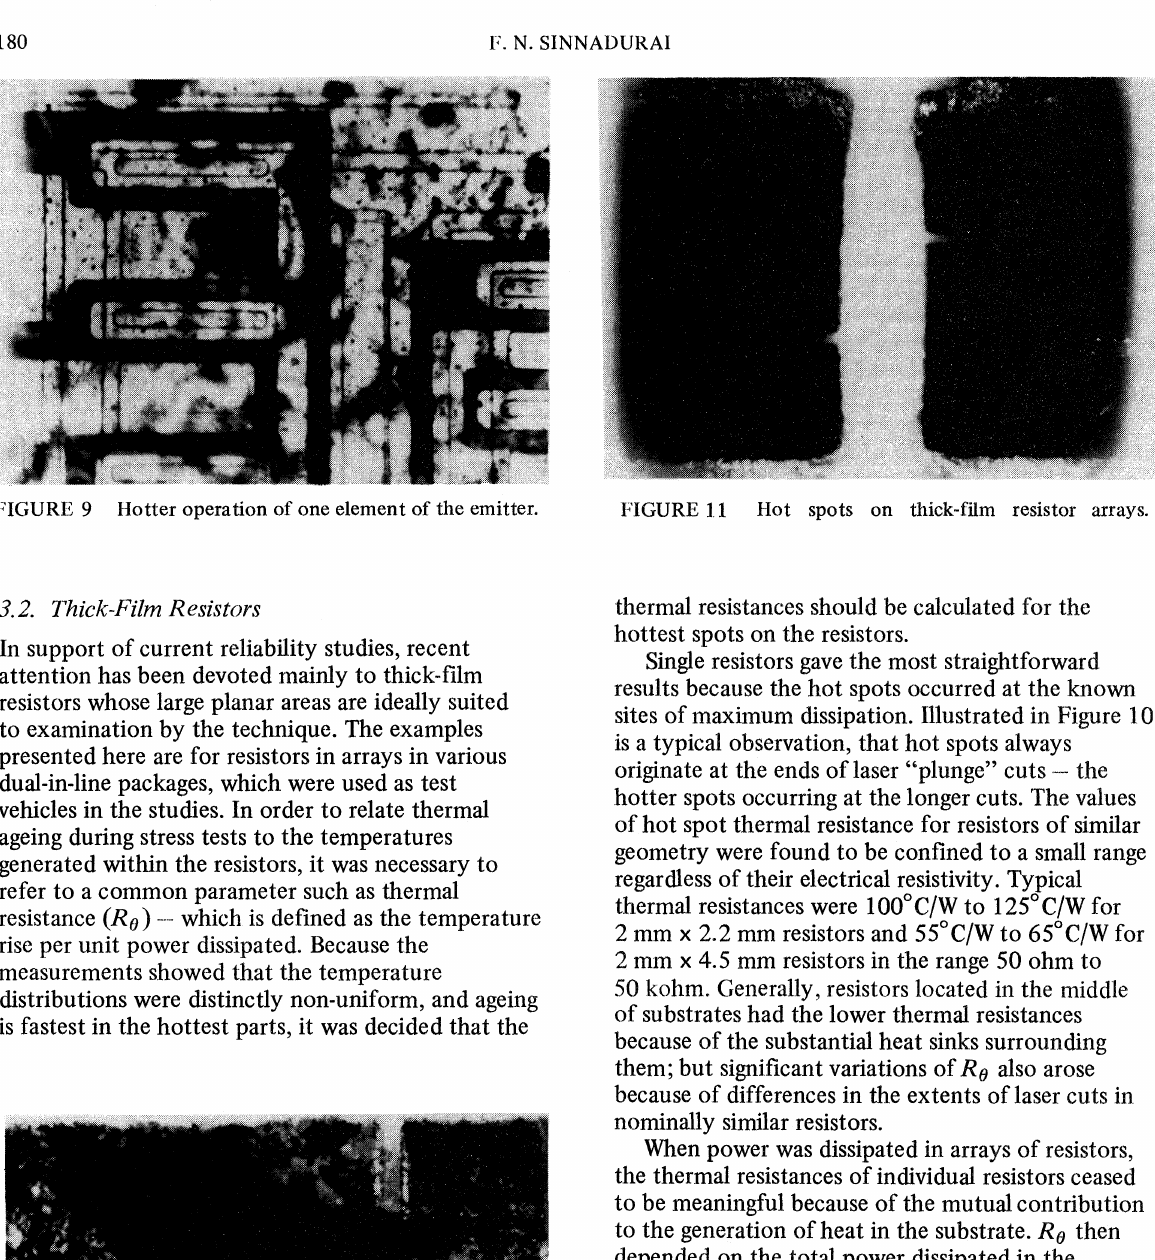
Hot spots on thick-film